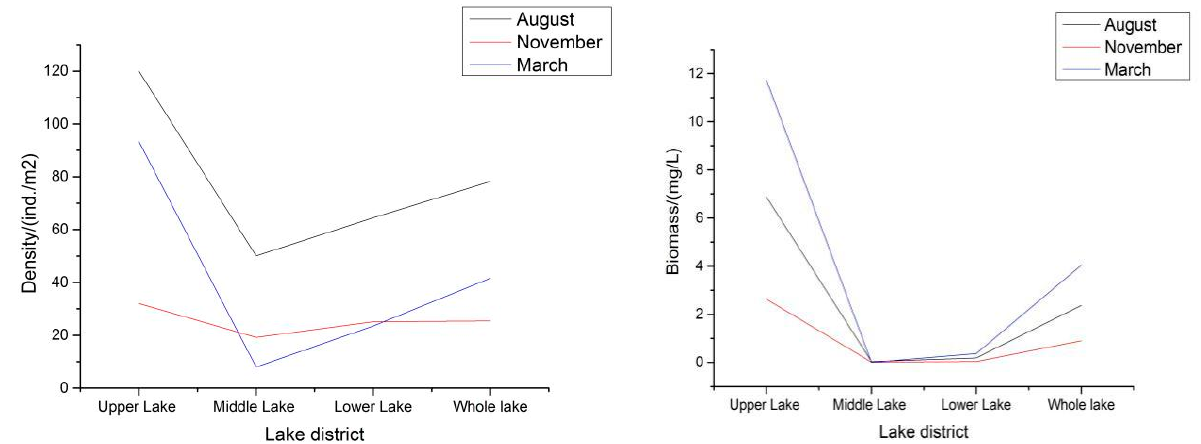
Figure 3. The trends in the density and biomass of benthos in each lake area of Shengjin Lake.